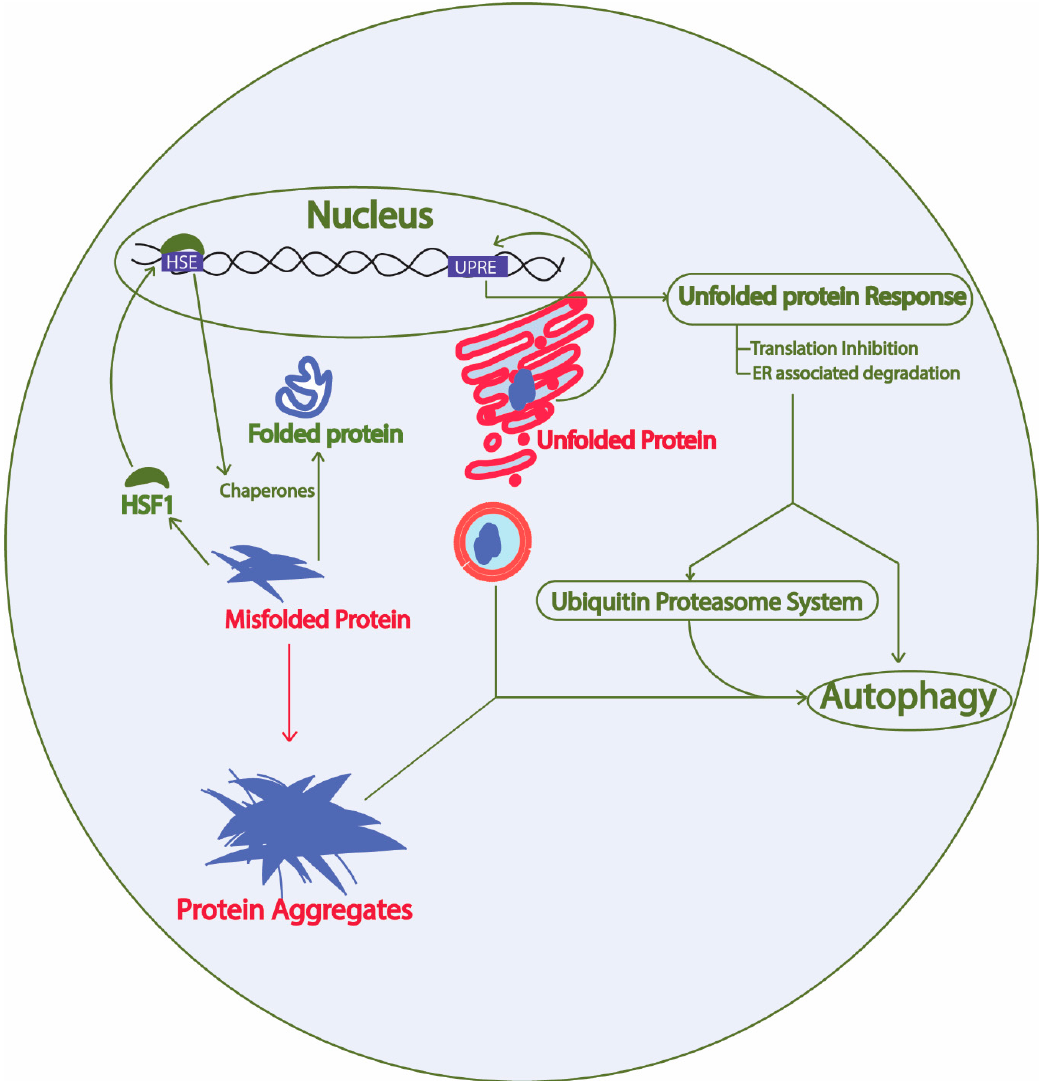
Figure 2. Proteostasis network involves protein synthesis, protein folding, heat shock response, unfolded protein response, ubiquitin proteasome system, and autophagy. Green arrow, protective; Red arrow, toxic; HSF1, heat shock factor 1; HSE, heat shock elements; UPRE, unfolded protein response elements. The proteostasis network involves protein synthesis machinery, protein folding, protein quality control, protein transport, and the overall turnover of proteins inside a cell. The presence of misfolded proteins in the cytosol trigger HSF1 activation, which activates promoters with HSE and results in expression of heat shock proteins that are either involved in protein disaggregation and refolding or clearance of the unwanted proteins through protein quality control mechanisms.